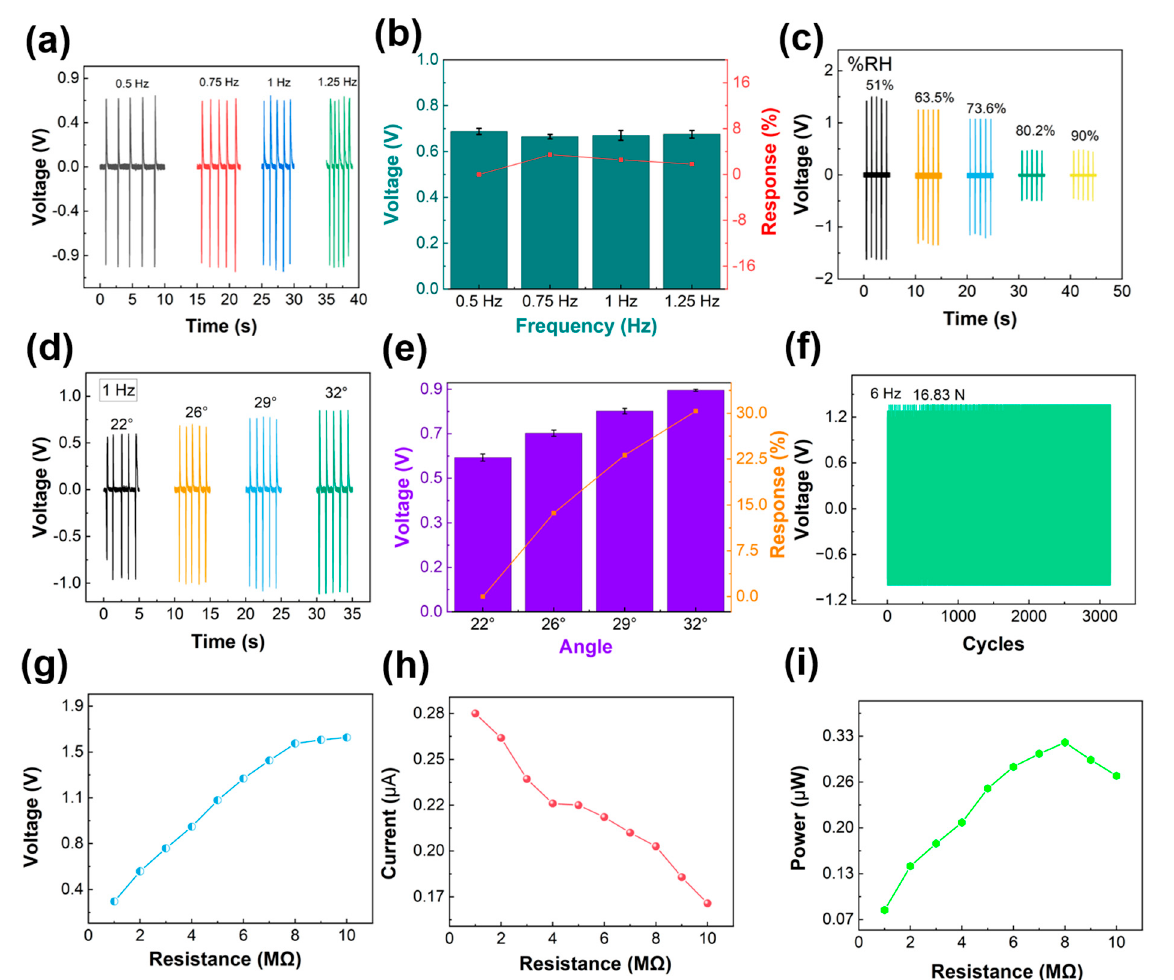
Figure 3. Electrical properties of SPTENG. ( a ) Voltage of SPTENG at different frequencies; ( b ) Response at different frequencies; ( c ) Voltage of SPTENG at different humidity; ( d ) Voltage of SPTENG at different angles; ( e ) Response at different angles; ( f ) Durability test; ( g – i ) The voltage, current, and power of SPTENG at different resistances.